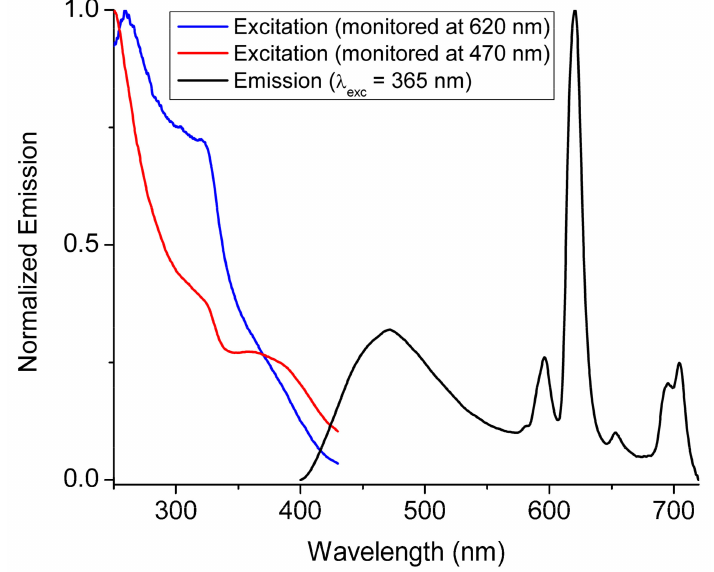
Figure 6. The solid-state emission and excitation spectra of compound 6. The excitation spectra are monitored both at the dabpdc 2 − (470 nm) fluorescence and the Eu 3 + emission (620